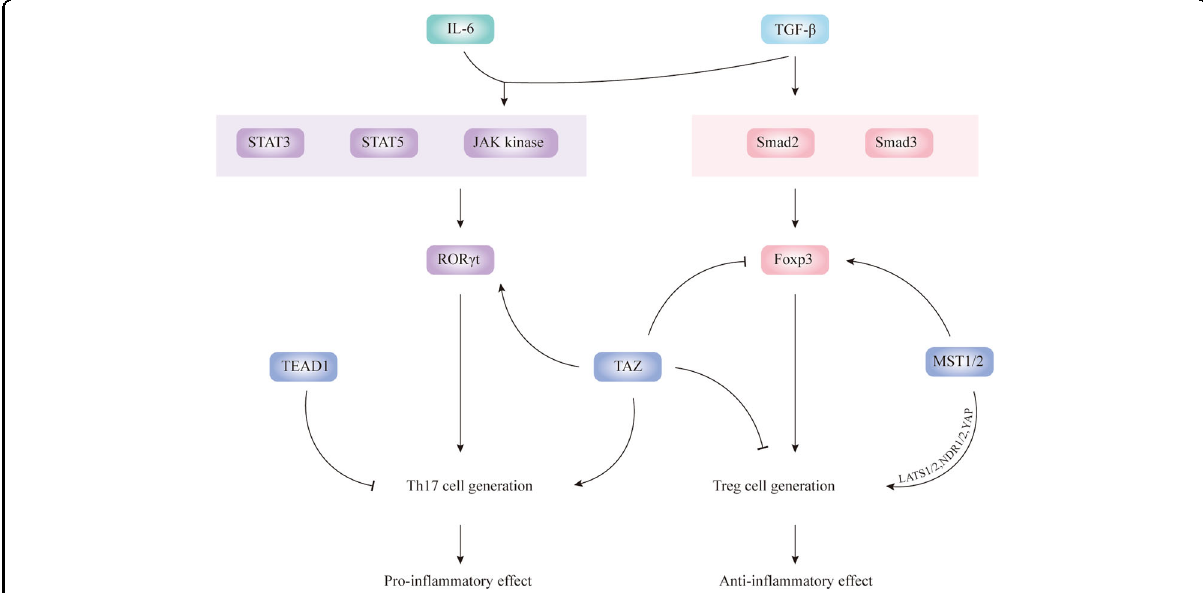
Fig. 3 Hippo pathway and immune in fl ammation. TGF- β stimulates Smad2 and Smad3, thereby activating Foxp3 and promoting Treg cell differentiation. TGF- β and IL-6 together stimulate JAK kinases and transcription factors STAT3 and STAT5, subsequently activating ROR γ t and Th17 cell generation. MST1/2 enhances the stability of Foxp3 and promotes Treg cell generation through LATS1/2, NDR1/2, and YAP. In contrast, TAZ inhibits foxp3 and attenuates Treg cell generation but promotes the process of Th17 cell generation. In addition, TEAD1 may hinder Th17 cell formation. Arrows and blunt ends indicate activation and repression,